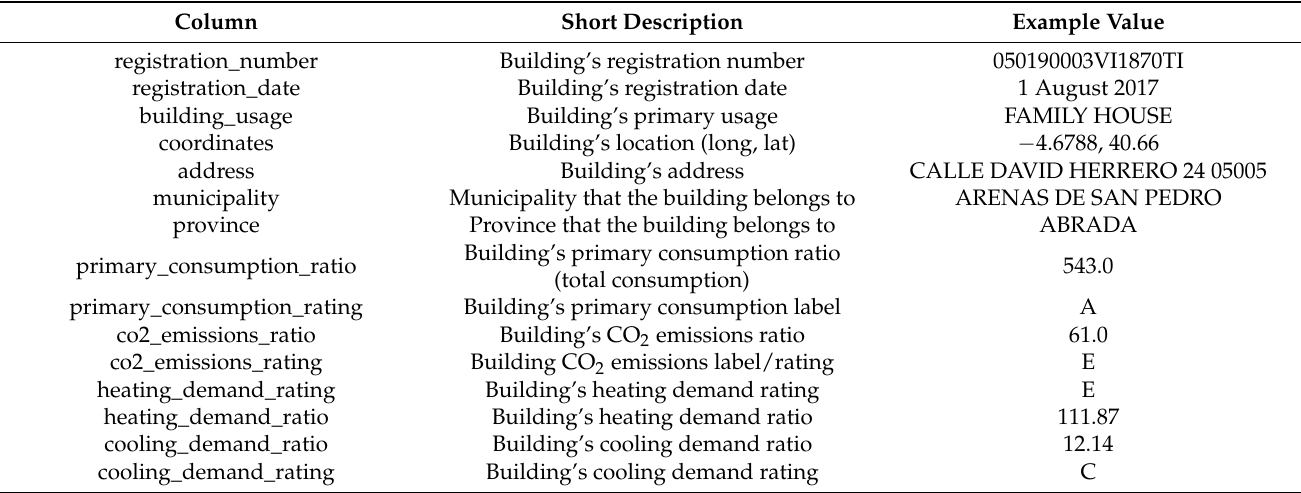
Table 2. EREN energy efficiency certificates